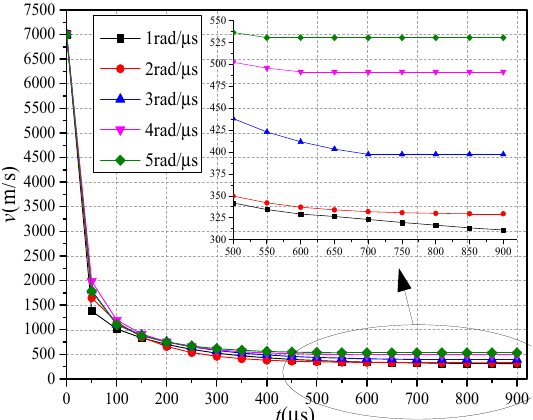
Figure 19. Attenuation curves of the translation velocity when the debris impacted the satellite tank with angular velocities of w y = 1 rad/ μ s, w y = 2 rad/ μ s, w y = 3 rad/ μ s, w y = 4 rad/ μ s, and w y = 5 rad/ μ s.